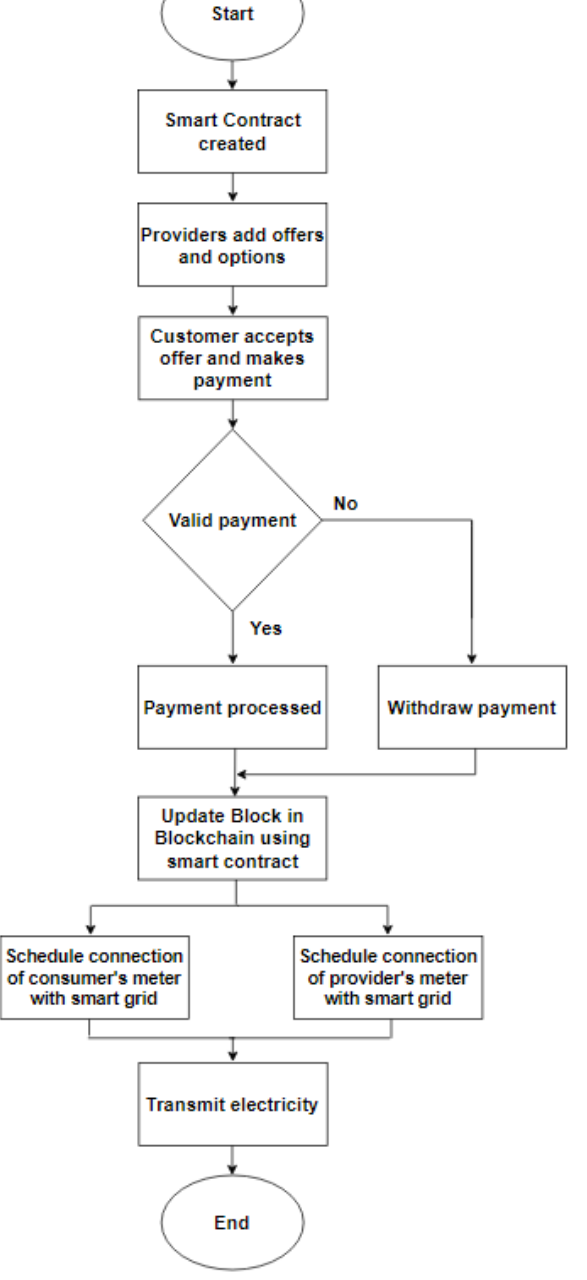
Figure 3. The flow diagram of blockchain-based smart grid